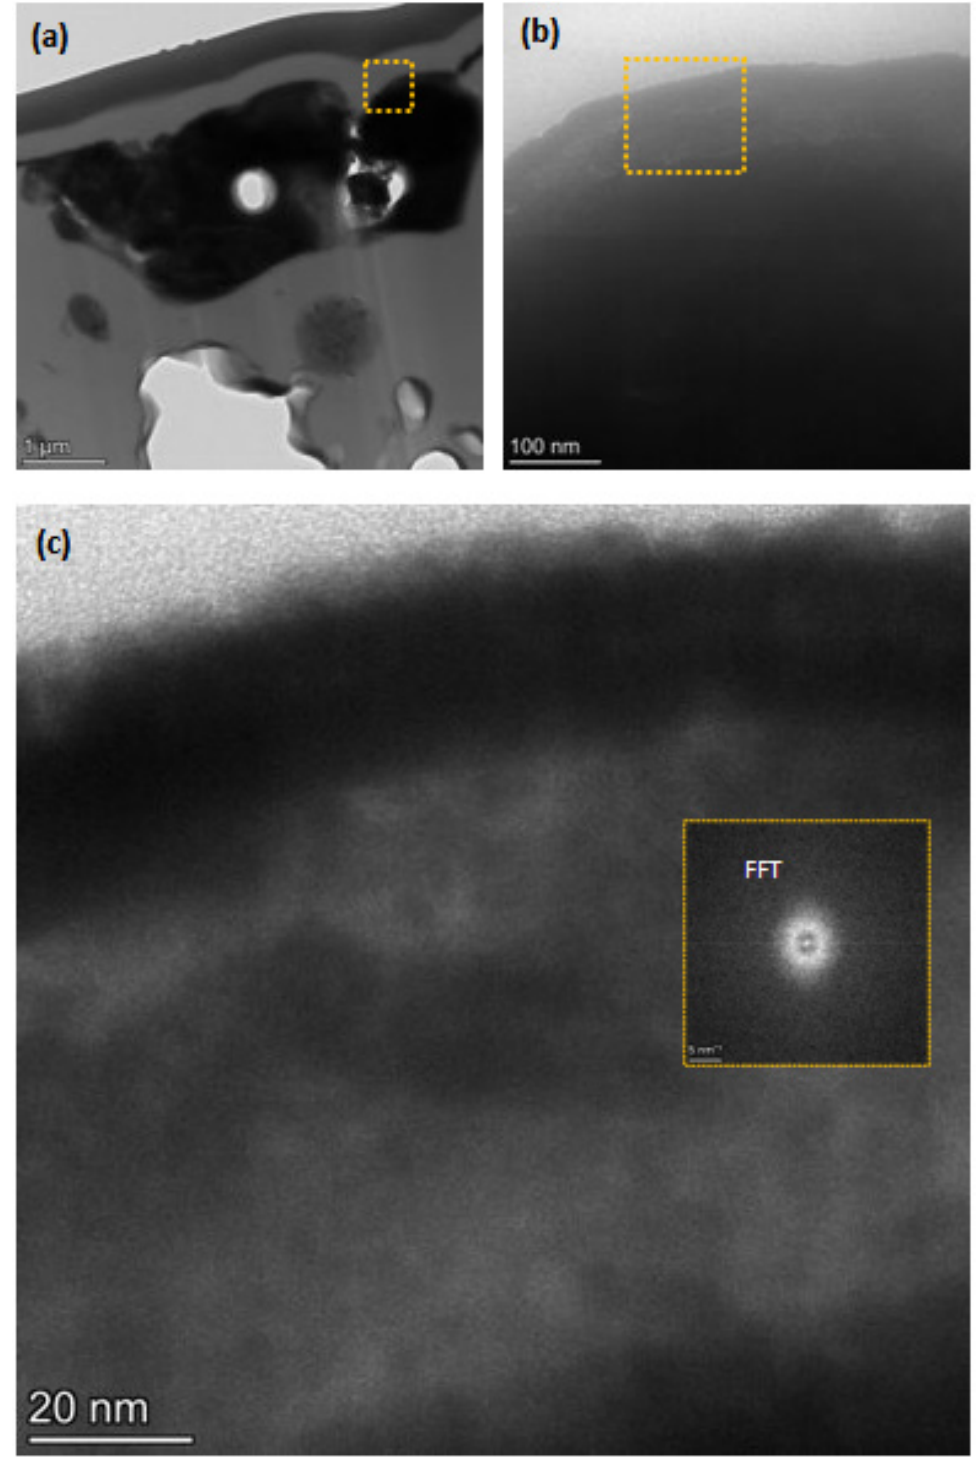
Figure 18. TEM image from STEM-EDS region 1213 at low magnification ( a , b ) (scales = 1 µ m and 100 nm, respectively) and high magnification ( c ) (scale = 20 nm), shows no crystalline lattice fringes, therefore it is an amorphous phase. The absence of diffraction spots in FFT is shown in the inset of ( c